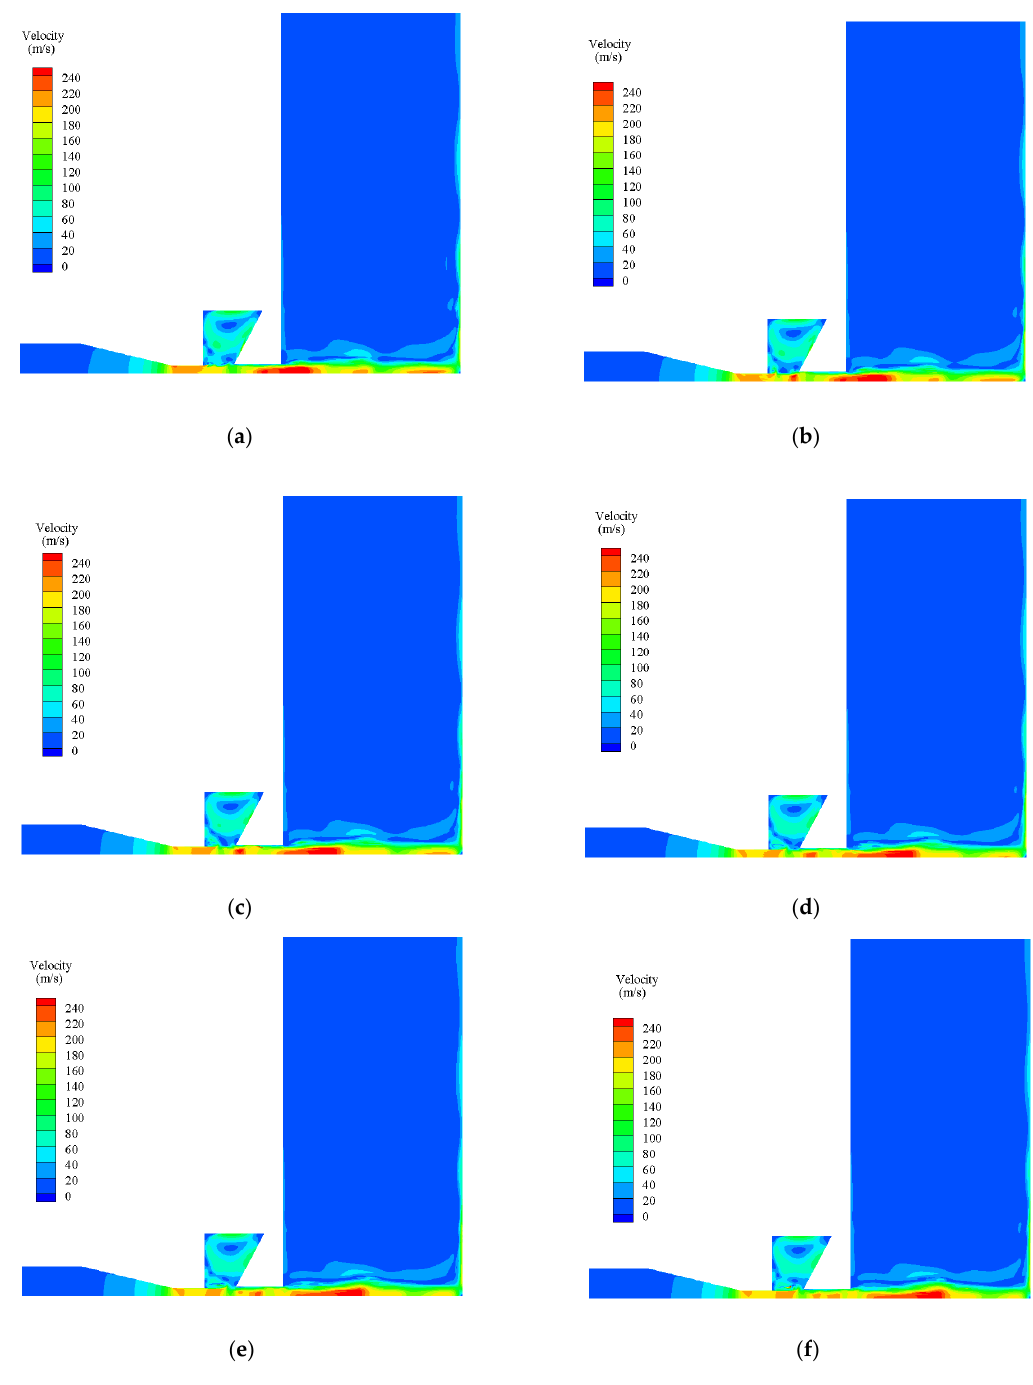
Figure 7. Time evolution of velocity contour. ( a ) t = t 0 + 0 ms; ( b ) t = t 0 + 10 ms; ( c ) t = t 0 + 20 ms; ( d ) t = t 0 + 30 ms; ( e ) t = t 0 + 40 ms; ( f ) t = t 0 + 50 ms.